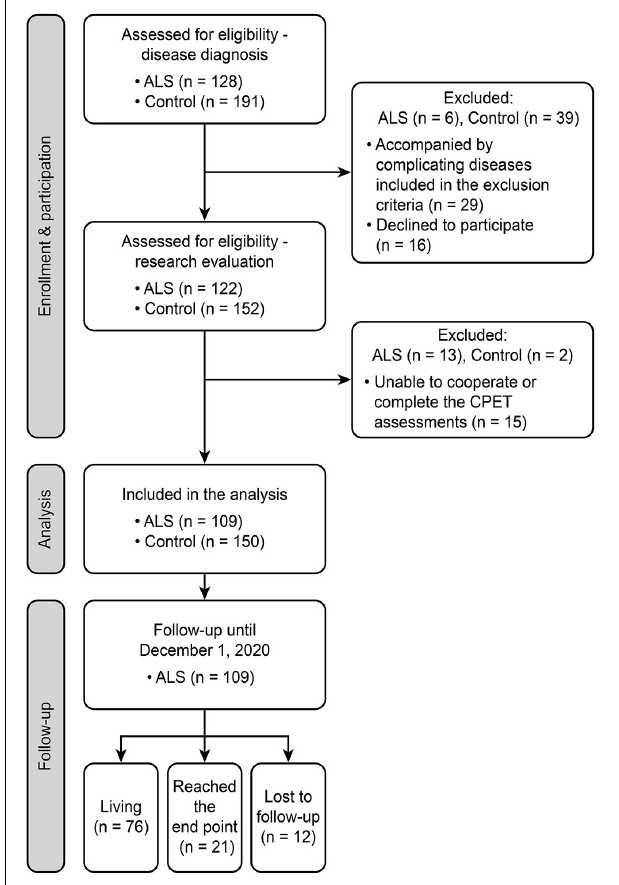
FIGURE 1 | Flowchart of the study design. A schematic summarizing the number of individuals during enrollment, participation, inclusion, and follow-up. ALS, amyotrophic lateral sclerosis; CPET, cardiopulmonary exercise testing.